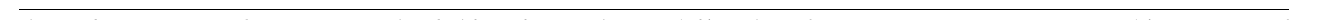
Figure 1 | uORF sequence features are associated with weak repressiveness. ( a , b ) Analysis of initiation context sequence in mouse. ( a ) Sequence motif over CDS starts ( ± 10 nucleotides around the annotated AUG start) constructed from CDS TE-weighted position-specific scoring matrices (PSSMs) of coding transcripts lacking uORFs. Height on vertical axis represents weighted relative entropy (WRENT) at individual positions. Inset shows sequence motif at uORF starts, using uORF TE-weighted PSSMs of coding transcripts with one non-overlapping uORF. ( b ) Cumulative distribution of WRENTscores around AUGs at various positions in coding transcripts. Dotted lines indicate median uORF and CDS WRENTscores, as well as the proportion of uORFs ( B 83%) with WRENT scores less than the median CDS WRENT score. ( c , d ) Analysis of initiation context secondary structure in mouse. ( c ) Meta-profiles of predicted secondary structure ensemble free energies (EFEs; sliding 35-nucleotide window) around AUGs in 5 0 leaders, CDSes, and 3 0 UTRs. A more negative EFE indicates more stable secondary structure. Red dotted lines indicate the positions (cid:2) 25 and þ 1 from ORF start that were used for subsequent analyses. ( d ) Cumulative distribution plot of initiation context secondary structure (at position þ 1 from the ORF start) of uORFs in transcripts with varying number of uORFs. Distributions of secondary structure EFEs for all uORFs and for CDS initiation contexts are indicated (dashed lines). ( e , f ) Distribution of uORFs. ( e ) ATG (that is, start codon; solid lines) and stop codon (dashed lines) moving average of positional trinucleotide biases in 5 0 leaders are plotted against their position with respect to the CDS start, for all 3 vertebrates. ATGs, but not stop codon trinucleotides are specifically depleted near the CDS start. ( f ) Depletion in the frequency of uORF ends (moving average over 24 nucleotides) relative to expected frequencies from shuffled 5 0 leaders, plotted against uORF-end position with respect to CDS, for all 3 vertebrates. uORF ends are specifically depleted in the 5 0 leader near the CDS, most significantly in zebrafish and mouse transcripts, less so in human